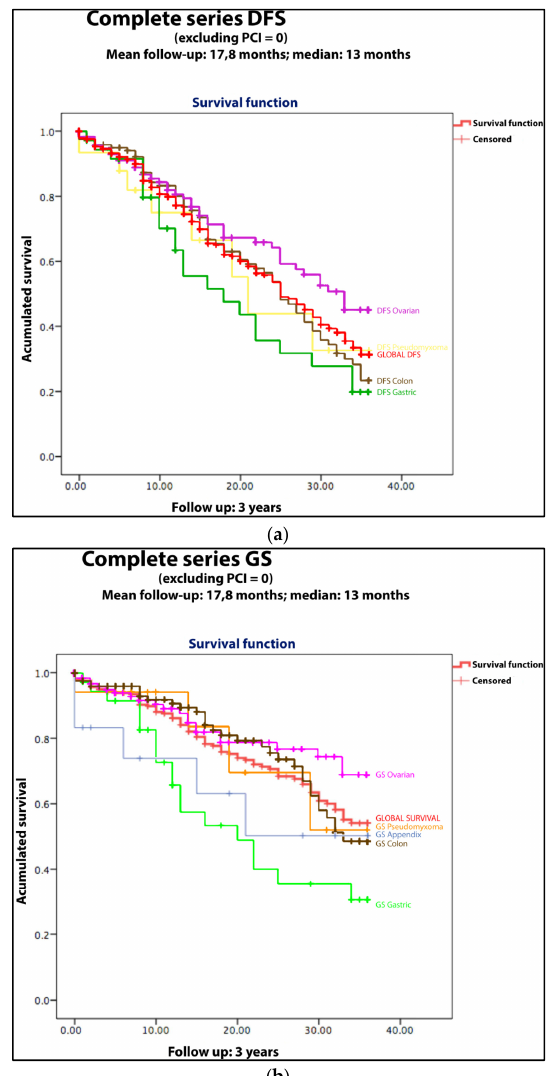
Figure 4. Survival curves by histology. ( a ) DFS: disease-free survival; ovarian (pink), global group (red), pseudomyxoma (orange) appendix (blue), colon (brown), gastric (green). ( b ) GS: global survival); ovarian (pink), pseudomyxoma (yellow), global group (red), colon (brown), gastric